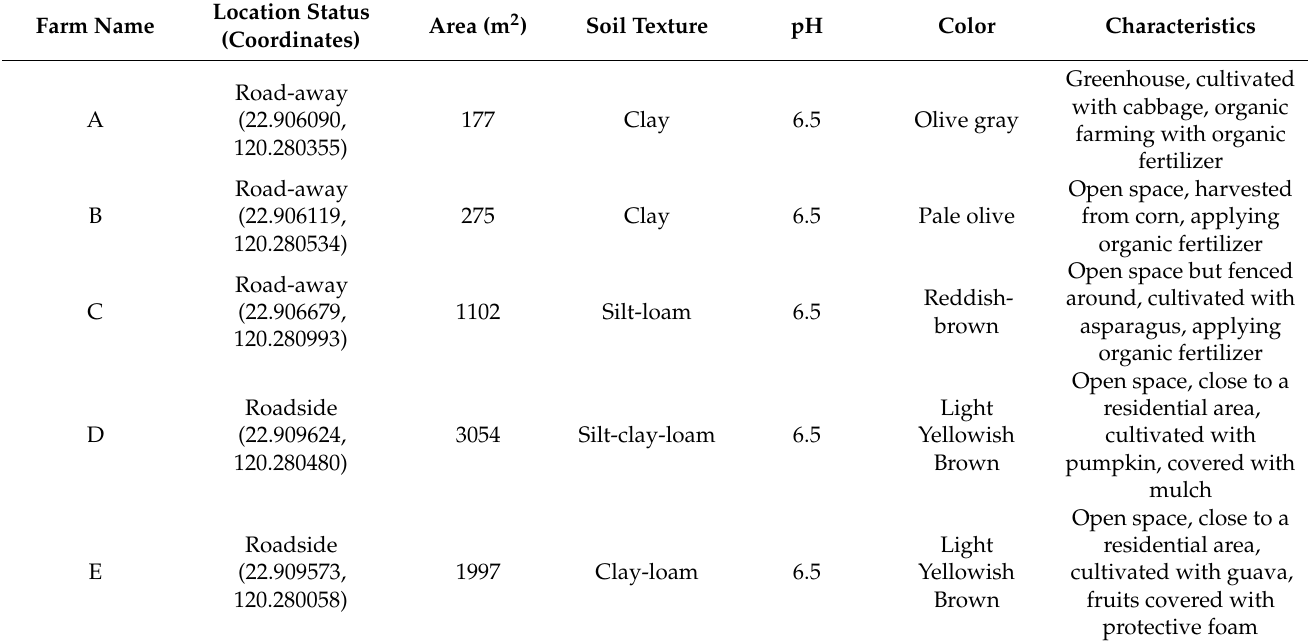
Table 2. Farmlands characteristics in the study